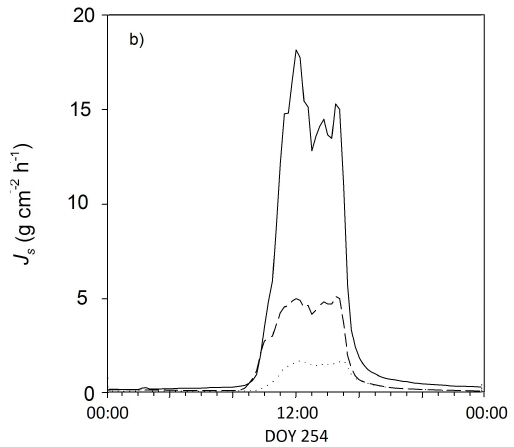
Figure 2. Representative daily courses of sap flux densities at the different xylem depths (0–2 cm, 2–4 cm and 4–6 cm below cambium) for ( a ) one Açaí palm and ( b ) one Cupuaçu tree over 24 h on 5 September 2011, J s = Sap flux density.